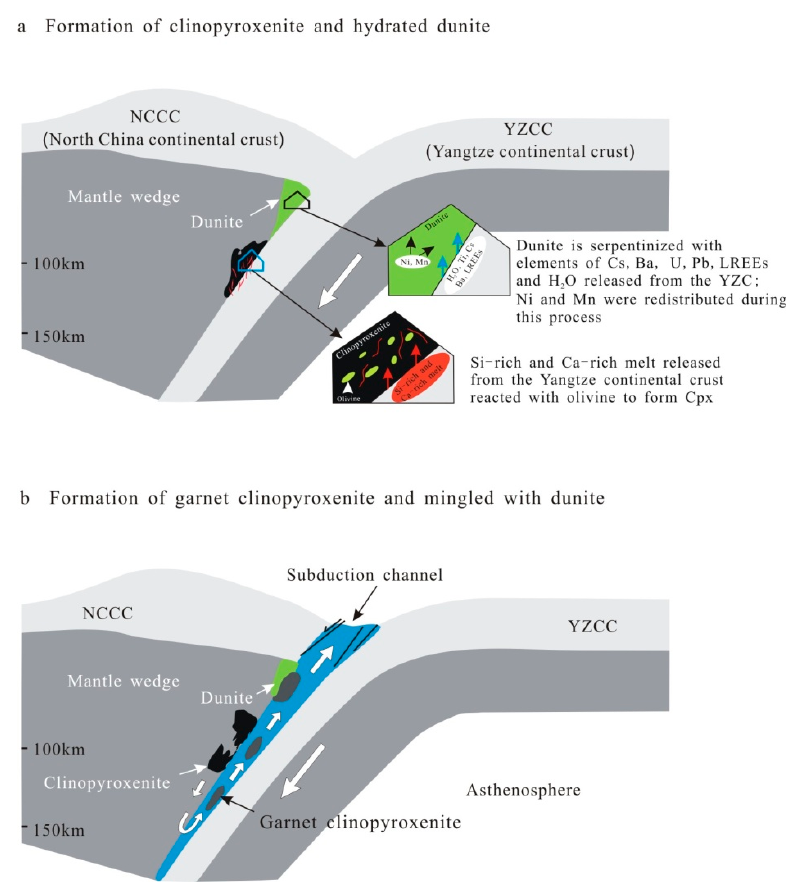
Figure 11. Formation and evolution model for the garnet clinopyroxenite and dunite in Hujialin, Sulu orogen. ( a ) Formation of the serpentinized dunite and clinopyroxenite. ( b ) Clinopyroxenite was incorporated into subduction channel and metamorphosed to garnet clinopyroxenite during deep subduction. It mingled with dunite during its exhumation at shallow depths.